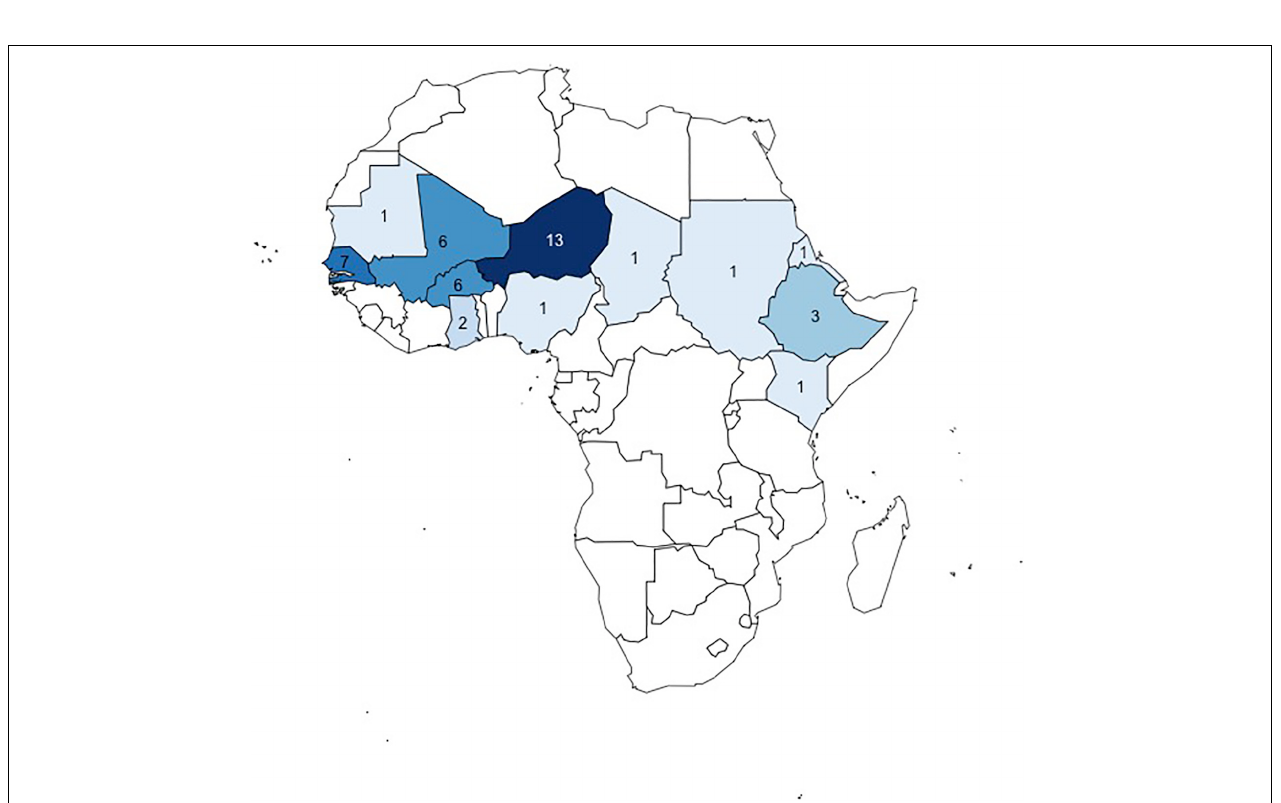
FIGURE 4 | Map showing the number of original data articles (indicated by color and number) for different African countries.